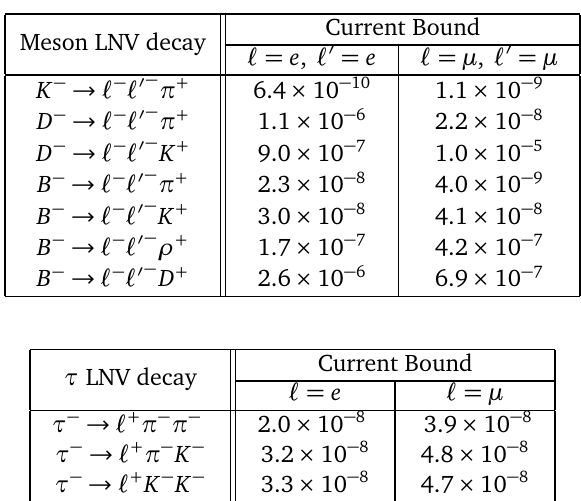
Table 1: Current bounds on a small set of LNV semileptonic meson and tau decays [ 1, 27,28 ]